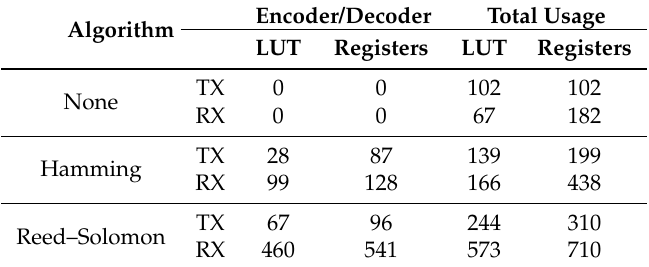
Table 3. Resource usage